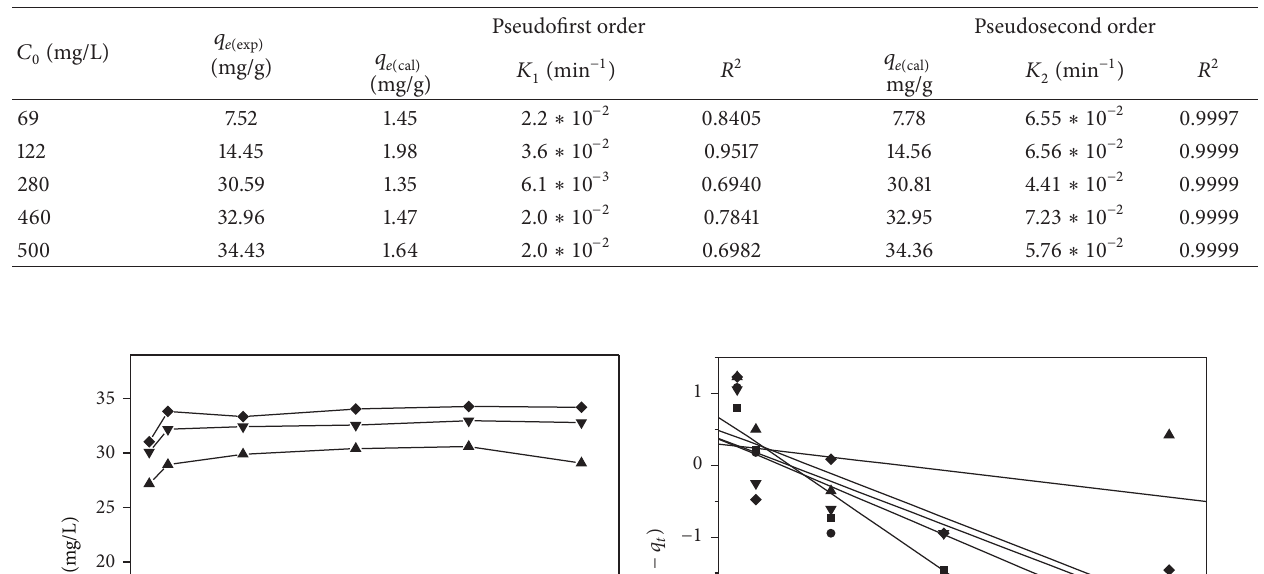
Table 3: Kinetics parameters for ammoniacal nitrogen adsorption on X/AC.